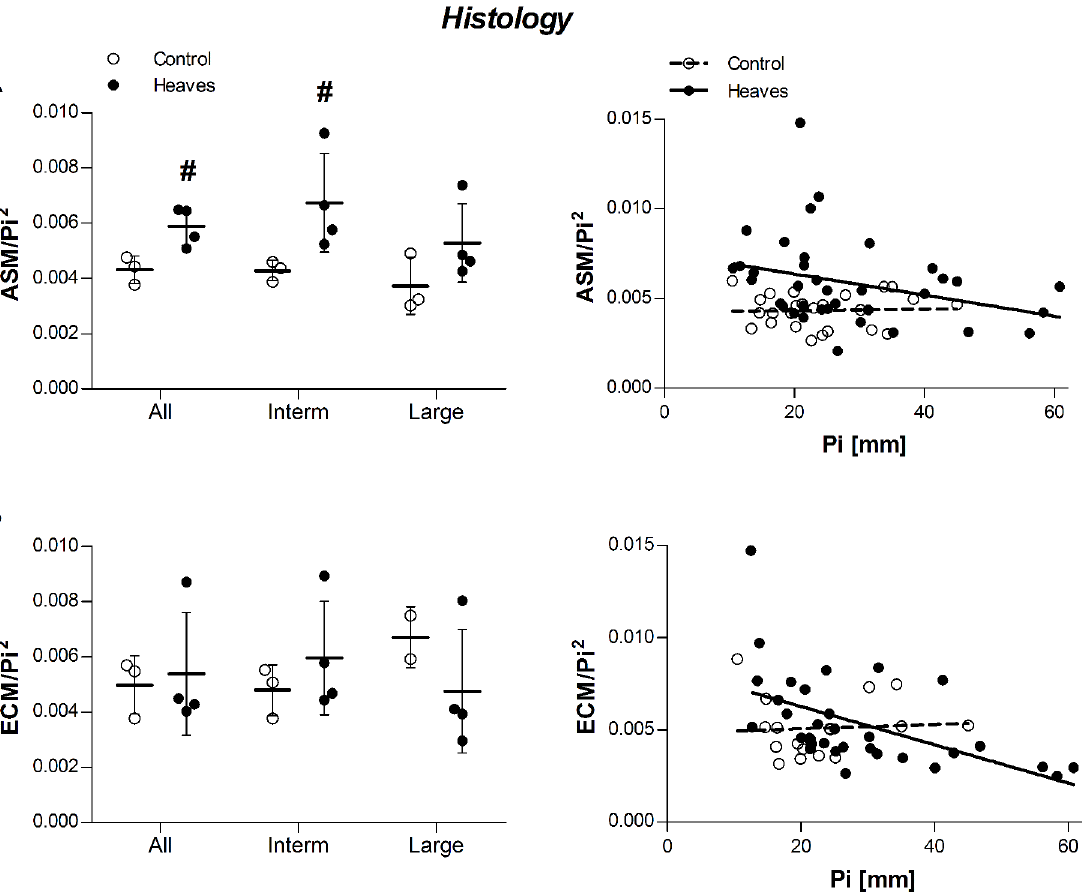
Fig 7. Effect of group and airway size on A ASM /Pi 2 (A) and A ECM /Pi 2 (B) measured on histological sections. Raw data (before statistical corrections) are presented as mean per animal in the graphs on the left, and as mean per airway the graphs on the right. Histological analysis confirmed in vivo and ex vivo EBUS findings concerning ASM remodeling. The slope of the A 2 relationship was similar between the 2 groups (p = 0.26), but heaves-affected ASM /Pi horses had significantly higher values compared to controls (p = 0.04). The slope of the A ECM /Pi 2 relationship tended to be different between the 2 groups (p = 0.07), but heaves-affected horses had similar values compared to controls (p = 0.26). #: significantly different from controls. * : significant difference between values of intermediate and large bronchi (pooling the two